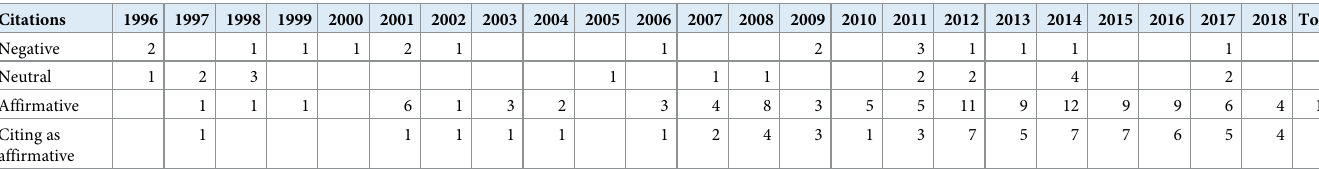
Table 2. Reception of Jones 1992.